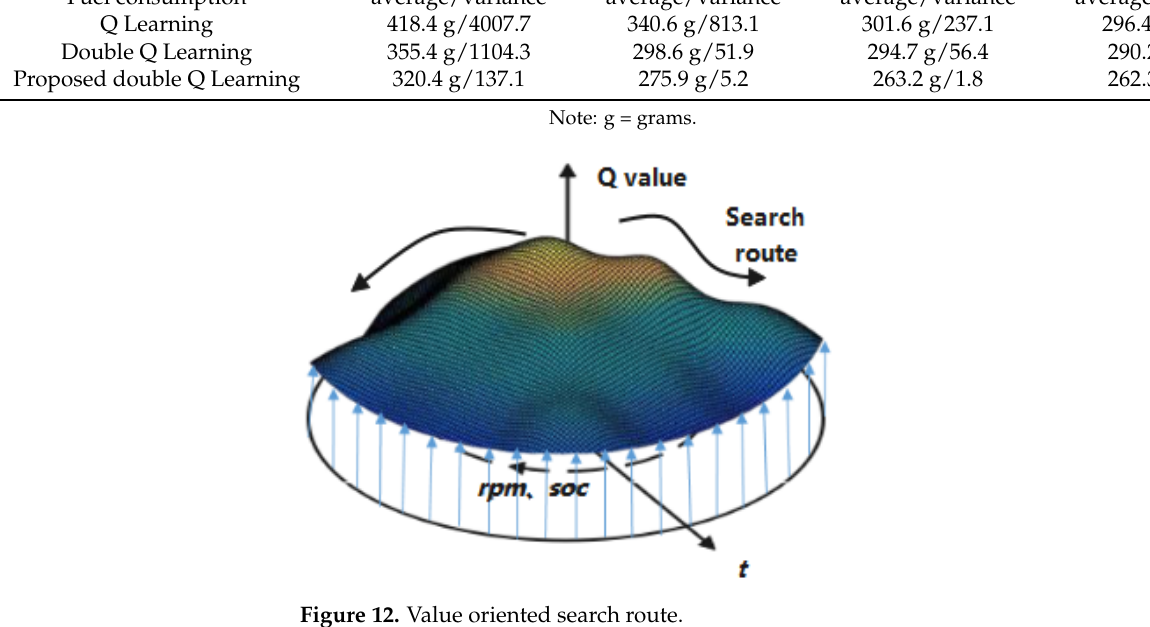
Figure 12. Value oriented search route. Table 4. Convergence comparison of different algorithms.